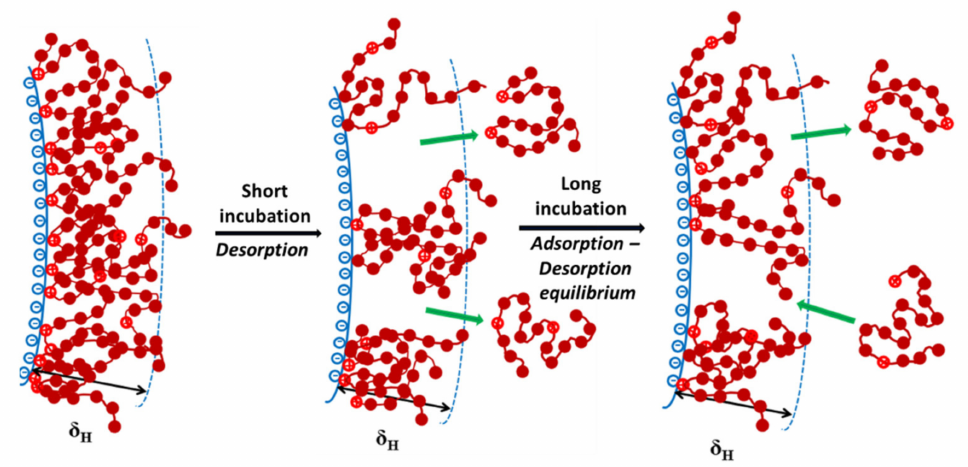
Figure 6. The polycation PTMC5M behaviors on the PSL colloidal particles with opposite charge in the long